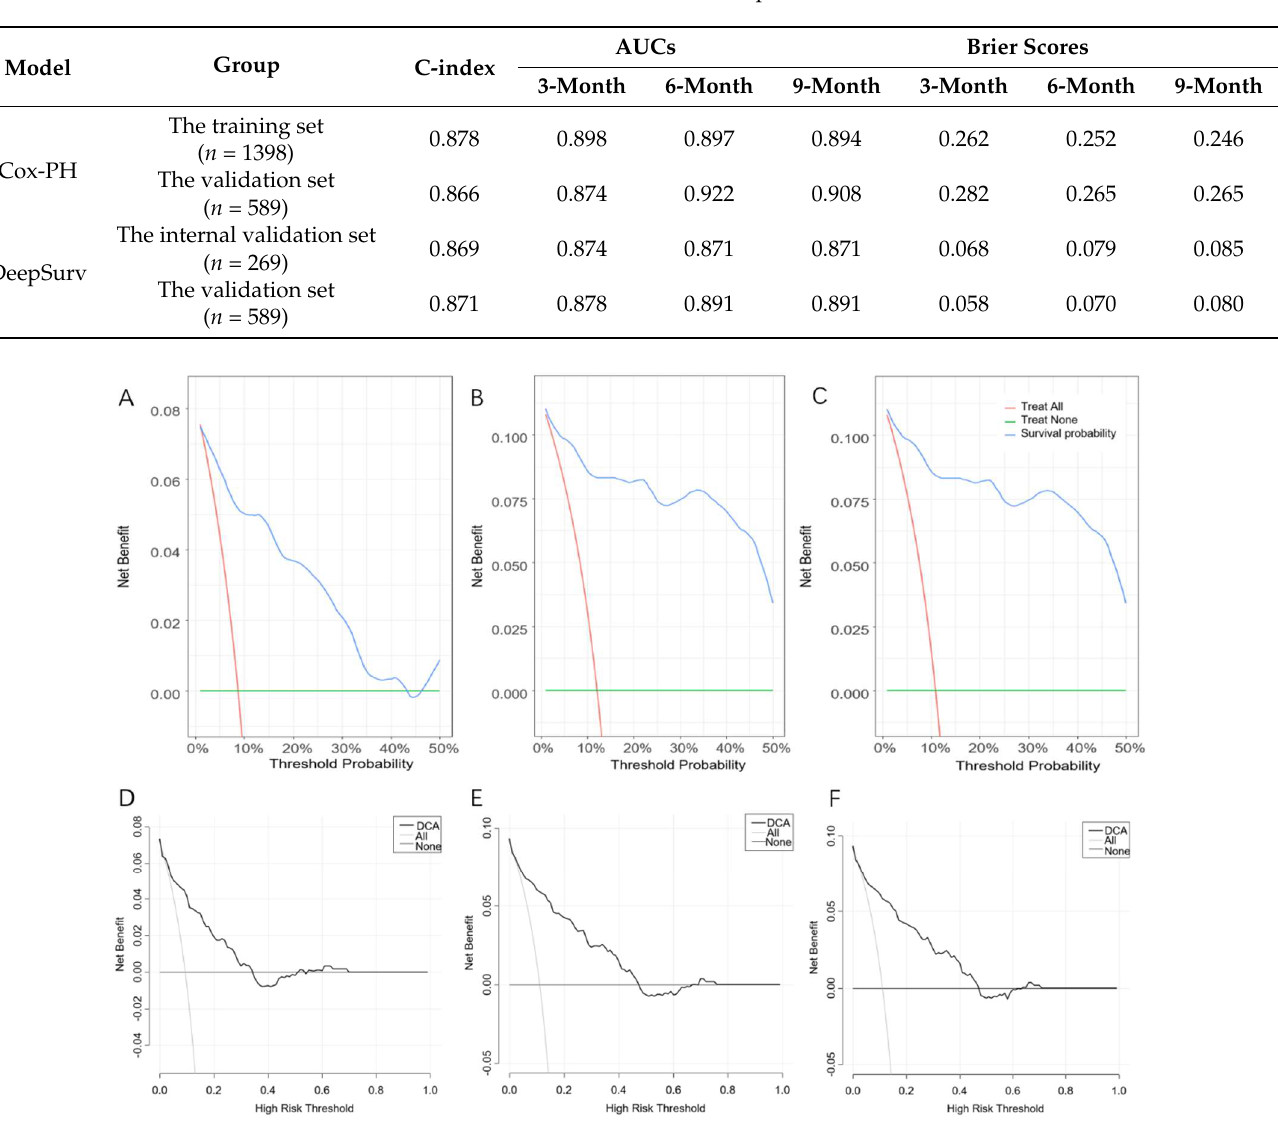
Figure 5. Decision-curve analysis of the Cox-PH ( A – C ) and DeepSurv ( D – F ) models for 3-, 6- and 9-month cancer-specific survival.